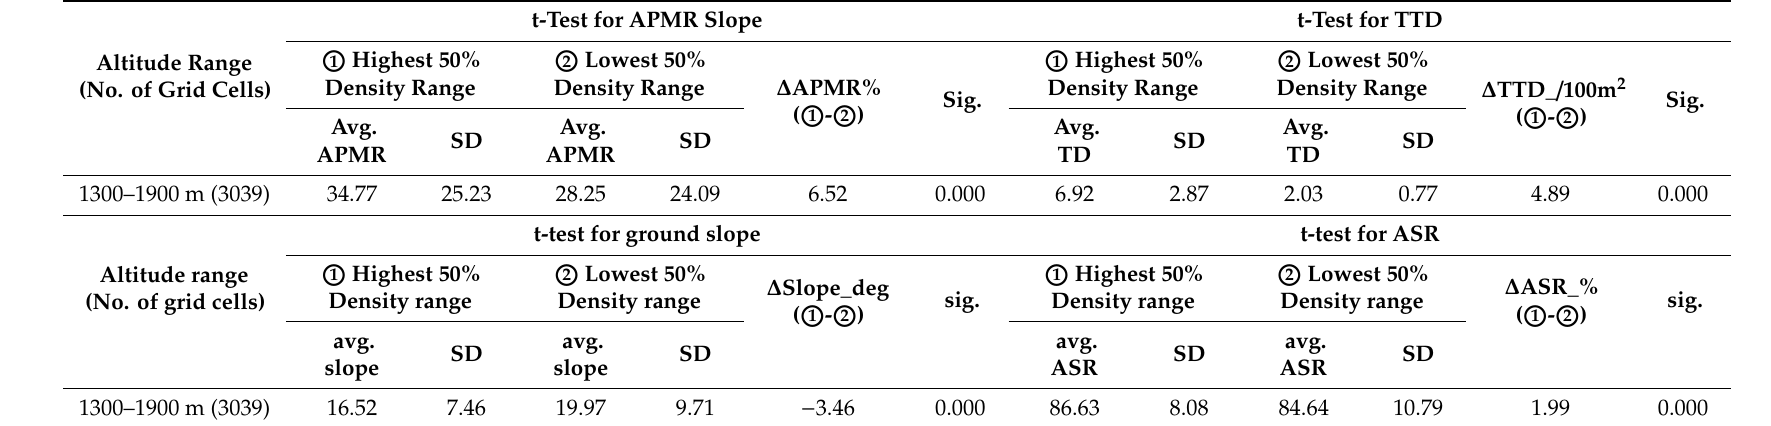
Table 4. t-test for APMR, tree density, ground slope and ASR between one cell group with highest 50% density range and another cell group with lowest 50% density range, from 1300 m to 1900 m in